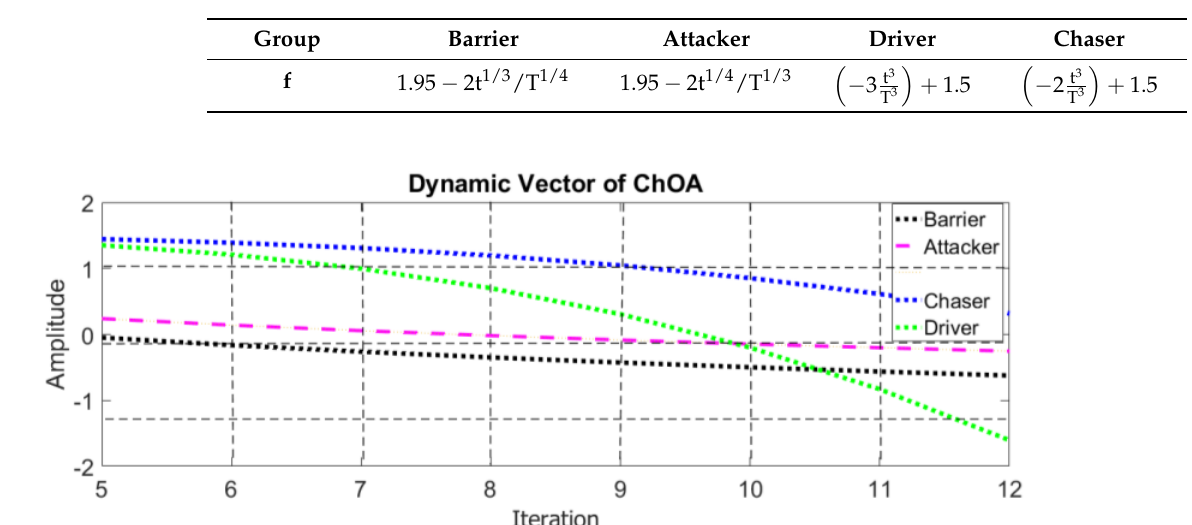
Figure 2. Mathematical model of dynamic coefficients ( f ) vector related to different groups of ChOA.